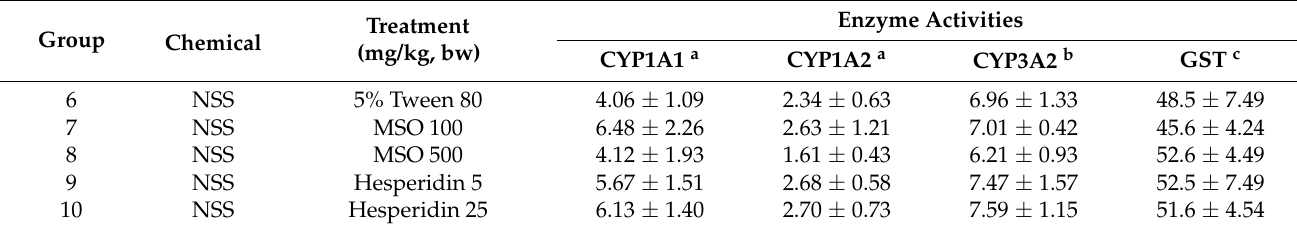
Table 2. Effect of the 5-week administration of MSO and active ingredients on xenobiotic metabolizing enzyme activities in the livers of